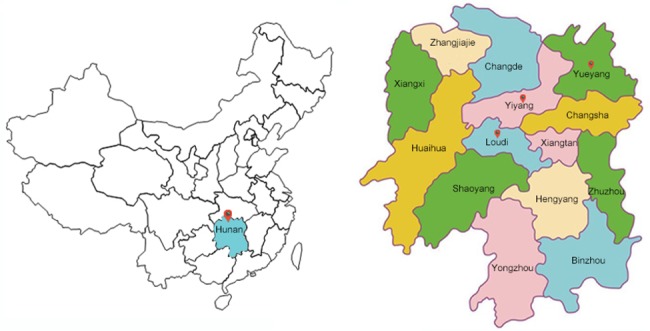
Geographical distribution maps of 14 cities surveyed in Hunan province.